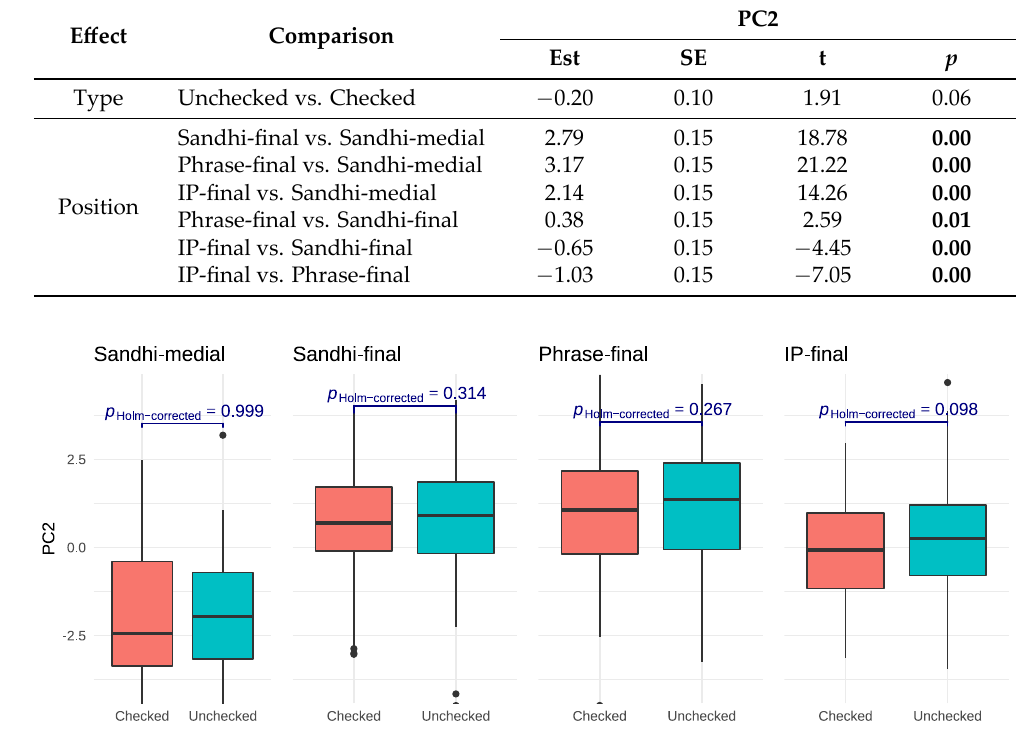
Figure 5. The variation of PC2 is influenced by phonemic type and prosodic position. Greater PC1 indicates higher periodicity during the vowel portion. The p ‑values at all prosodic positions are insignificant ( p > 0.05, shown in blue); this indicates that the PC2 differences between checked and unchecked syllables are insignificant at all prosodic